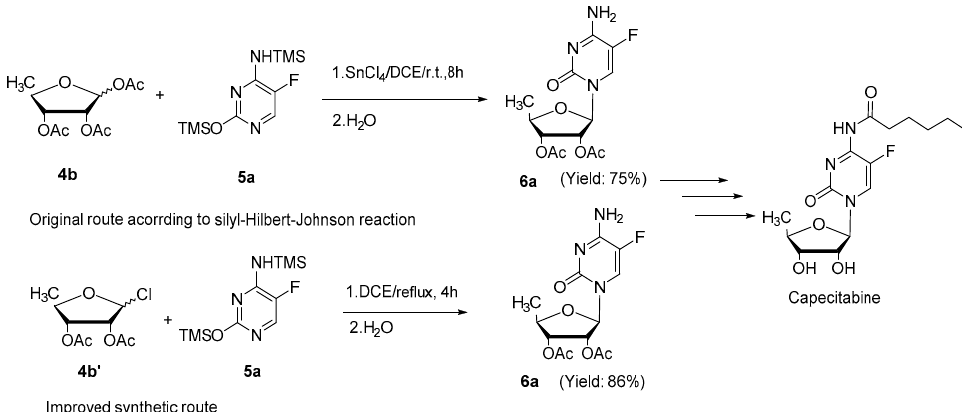
Figure 4. Application to the preparation of Capecitabine.